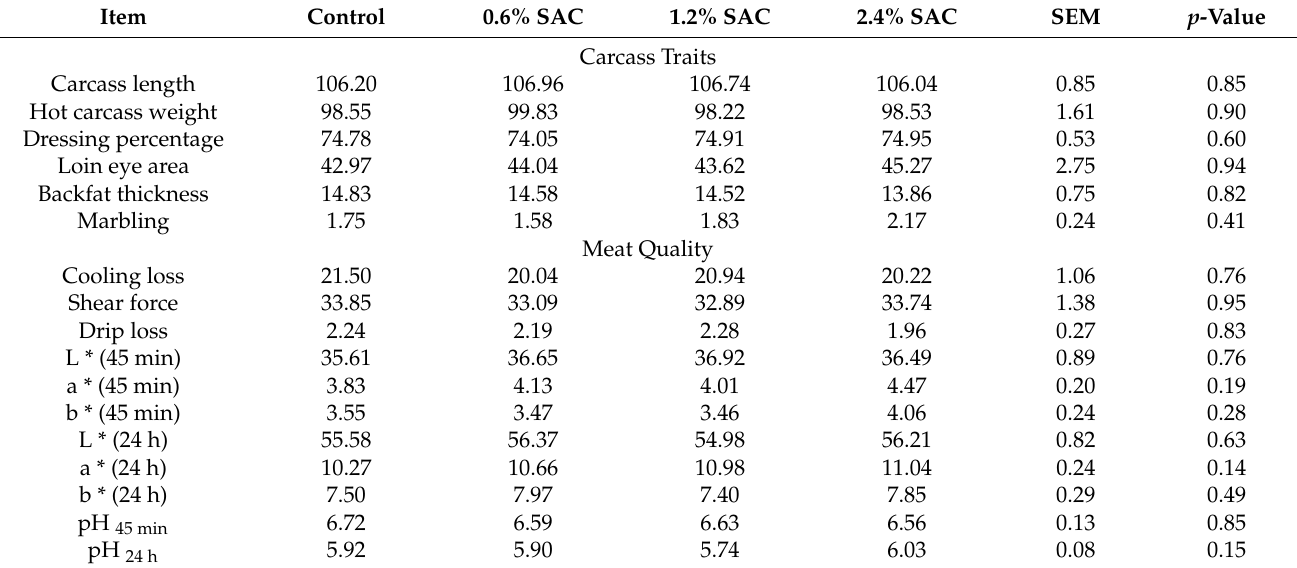
Table 11. Effects of dietary Selenium Auricularia cornea culture supplementation on carcass traits and meat quality of pigs in Exp. 2.